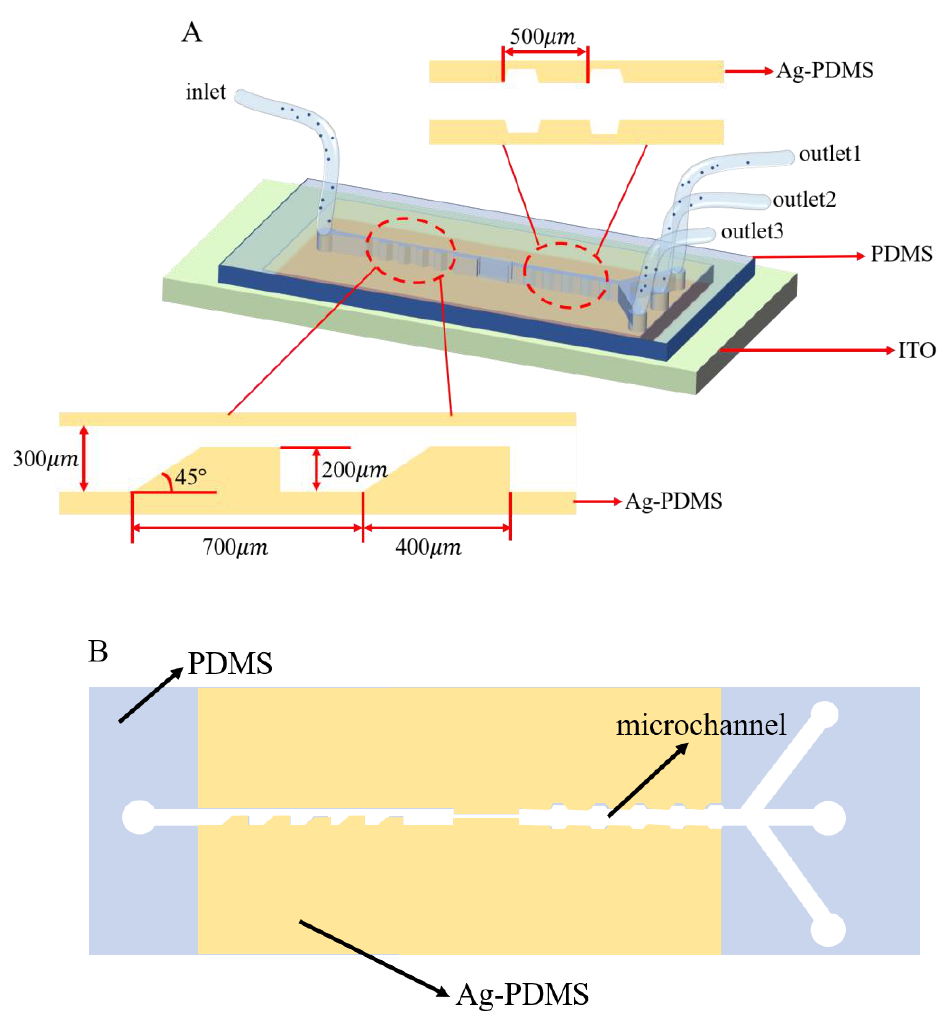
Figure 1. ( A ) Design of the microchip in the particle separation device. The micro-device consisted of one inlet, the CEA channel region, and three outlets. ( B ) Schematic diagram of Ag-PDMS electrode layer